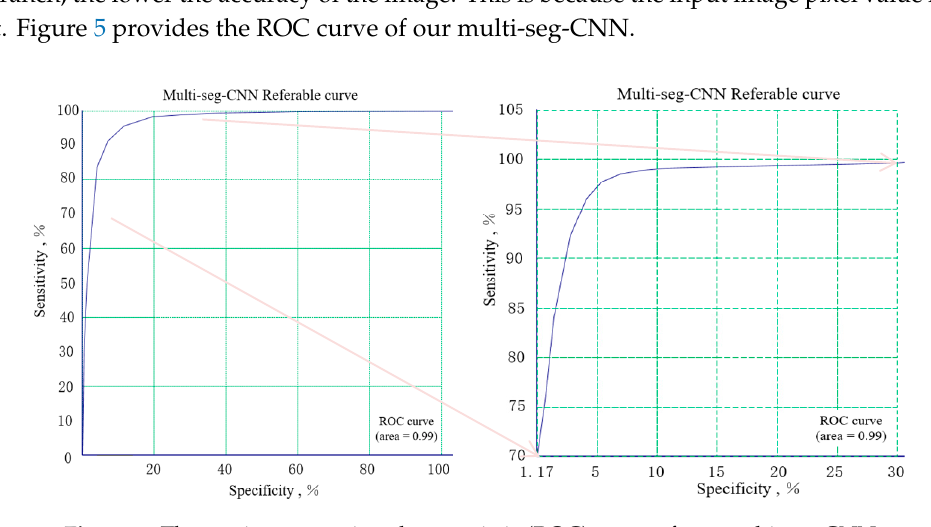
Figure 5. The receiver operating characteristic (ROC) curve of our multi-seg-CNN.